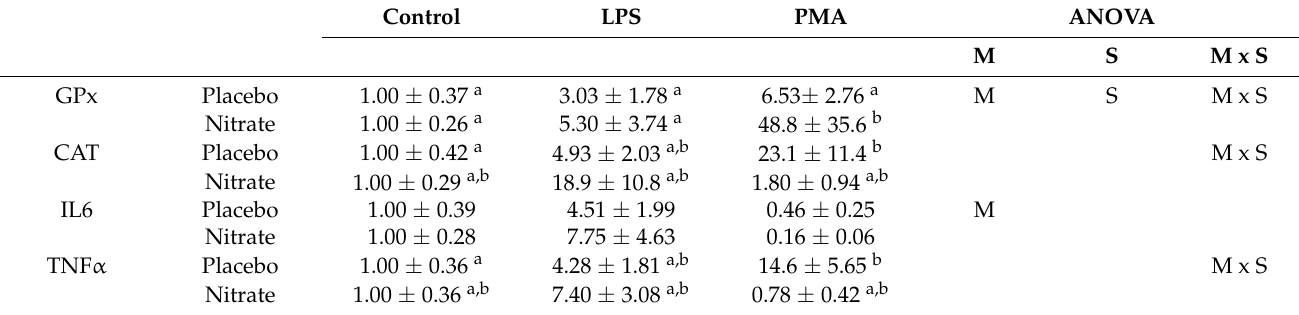
Table 4. Effects of dietary nitrate supplementation and ‘in vitro’ immune stimulation with lipopolysaccharide (LPS) or phorbol myristate acetate (PMA) on antioxidant and inflammatory gene expression in